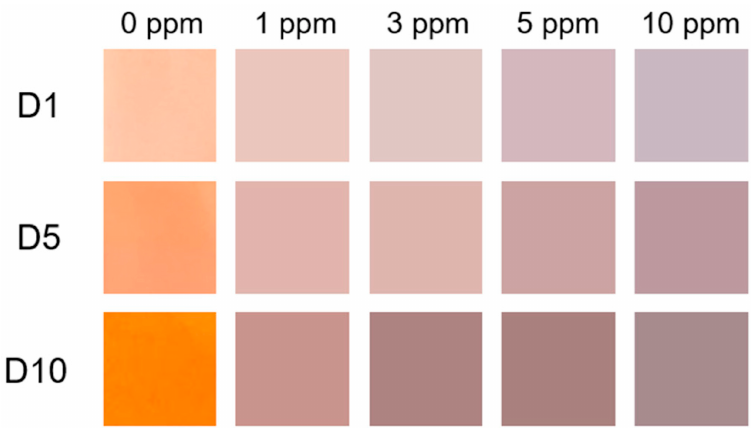
Figure 7. Color changes of each nano fi ber sensor after exposure to various NH 3 concentrations (1, 3, 5, and 10 ppm). Nano fi brous sensors D1, D5, and D10 contain 1%, 5%, and 10% of the dye, respectively. From [166], copyright (2020), originally published under a CC-BY license.